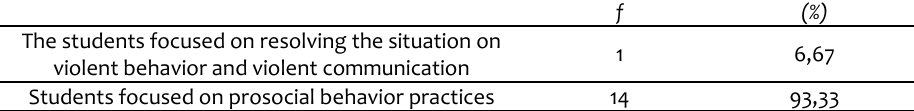
Table 6. Students' behavior in problem situations after the